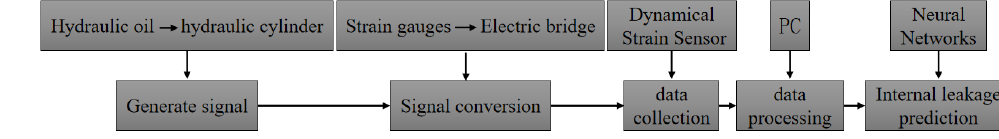
Figure 1. Flow chart of measurement principle.